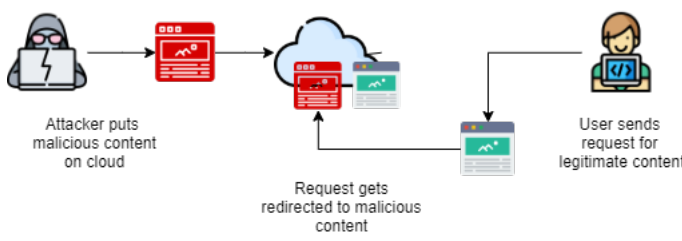
Figure 10. Graphical representation of a malware injection attack [92].